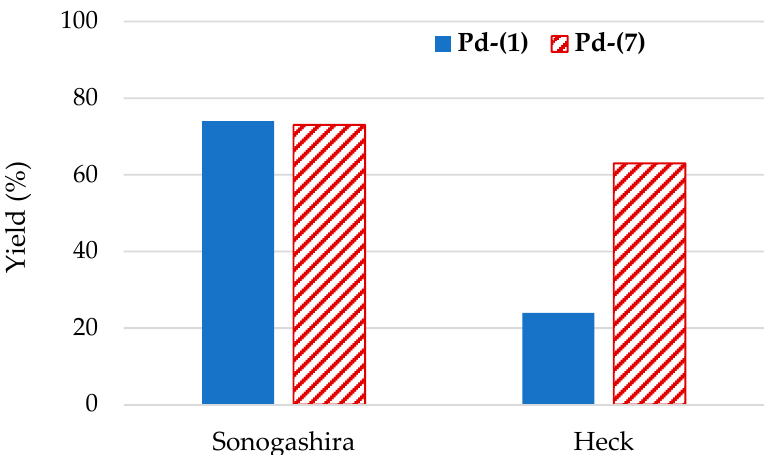
Figure 4. Yields obtained for Sonogashira and Heck C-C couplings catalyzed by Pd-scorpionates formed in situ.